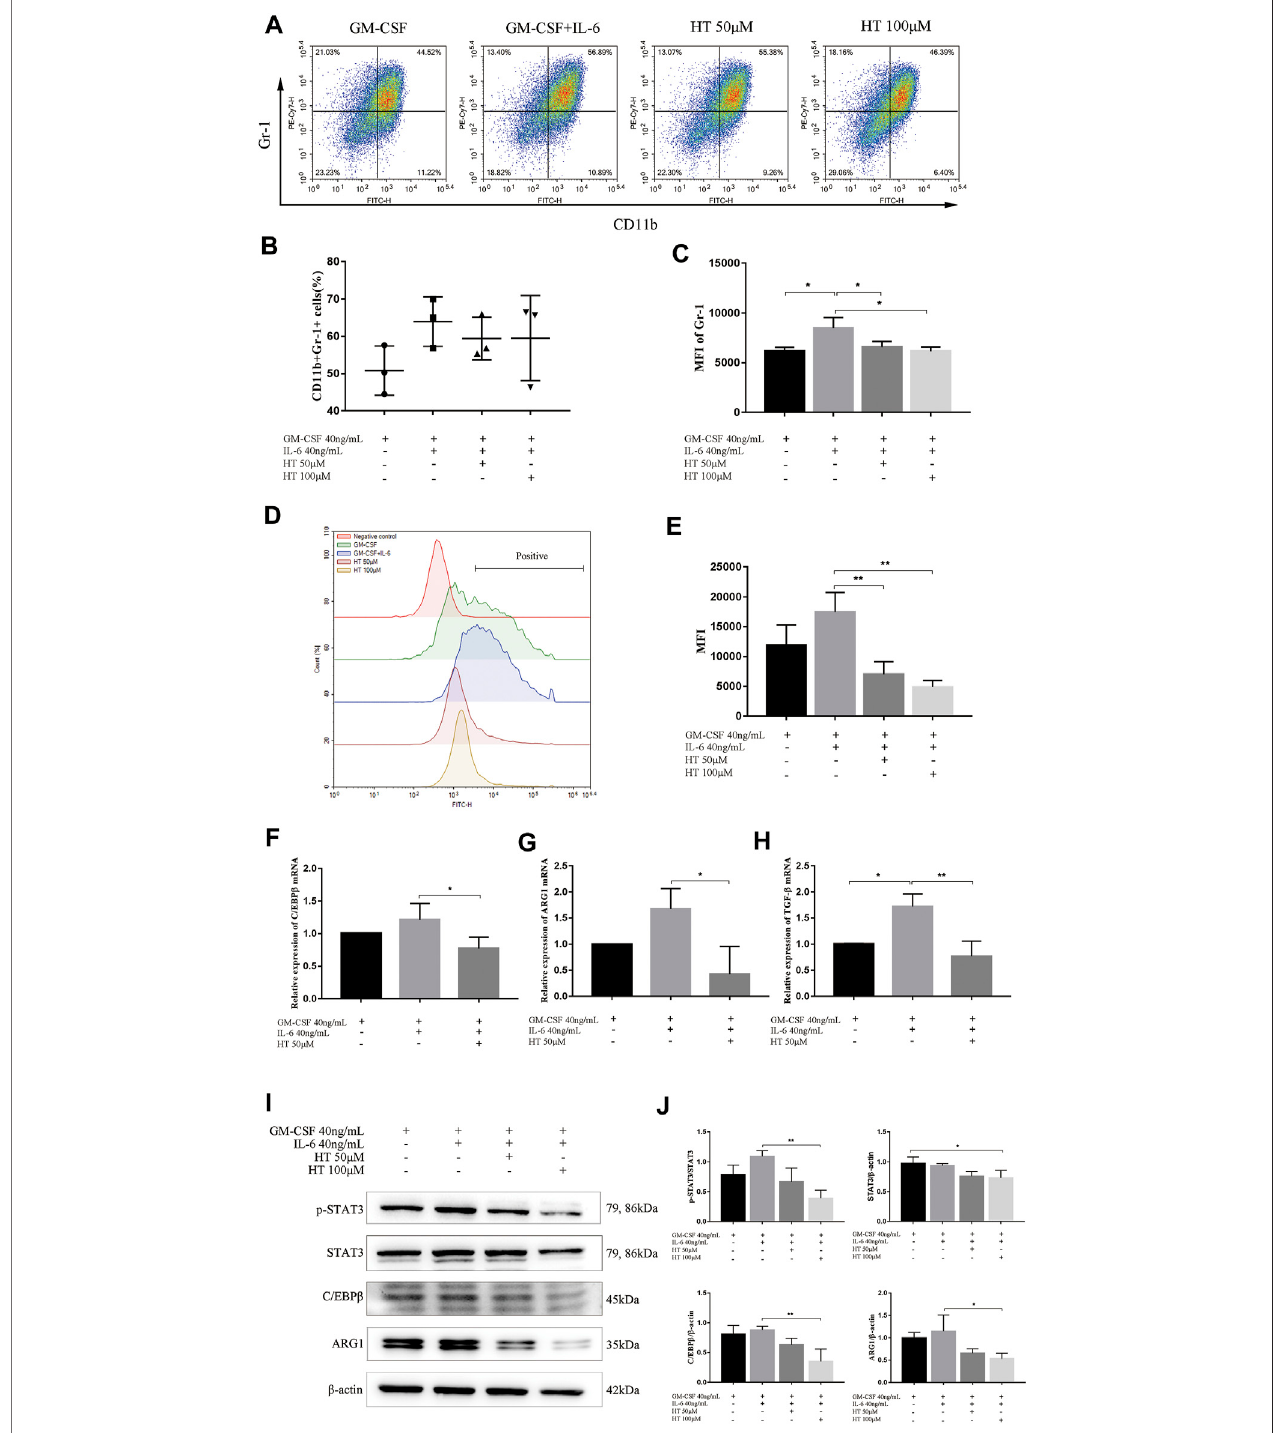
FIGURE 4 | Effect of HT on the differentiation, function and signal pathway of BM-derived MDSCs. The BM cells of healthy C57BL/6 mice were isolated and supplemented with 40 ng/ml GM-CSF or/and 40 ng/ml IL-6 to induce differentiation of MDSCs. In addition, different concentrations of HT were added during this process. The proportion of MDSCs (CD11b + Gr-1+) and MFI of Gr-1 were measured by fl ow cytometry (A – C) (* p < 0.05). The ROS production of MDSCs in different treatmentgroupswasmeasuredusingDCFH-DA (D) .TheirMFIwasanalyzedandcompared (E) (** p < 0.01).ThetranscriptionlevelsofC/EBP β ,ARG1andTGF- β in MDSCs of different treatment groups were detected by qPCR (F – H) (* p < 0.05, ** p < 0.01). After HT intervention, the expression of C/EBP β , STAT3, and ARG1 in MDSCs was detected by western blot (I) . The integrated density of the target proteins was analyzed through Image J (J) (* p < 0.05). All analysis was based on three independent